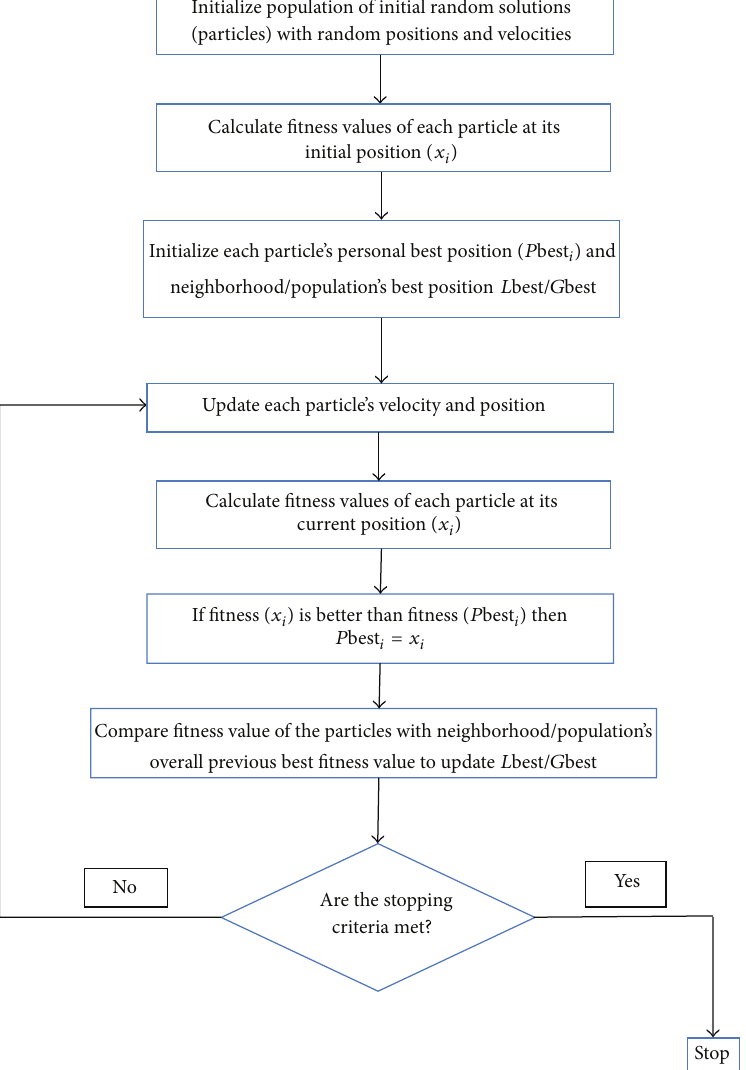
Figure 1: Flow diagram illustrating the standard particle swarm optimization (PSO)